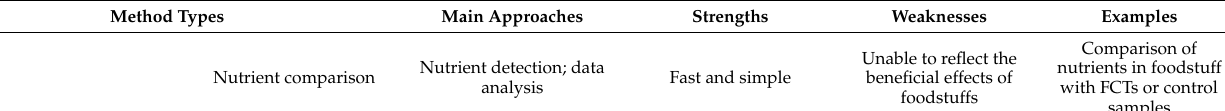
Table 2. Advantages and disadvantages of different types of